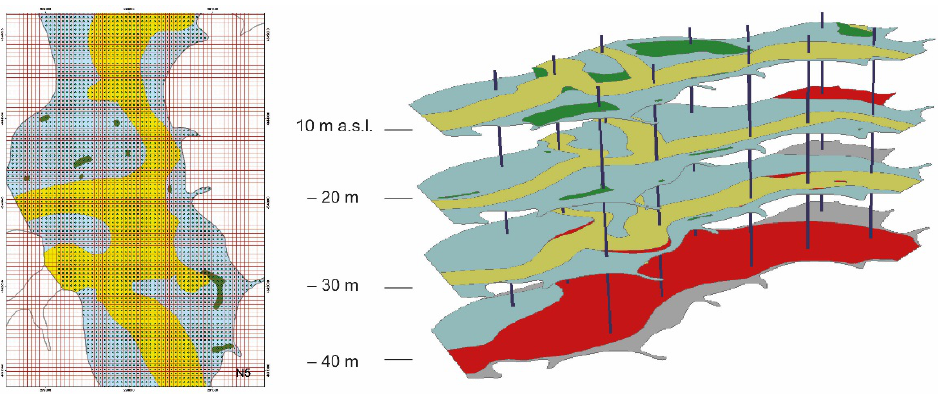
Figure 6. Rasterization of the model with a cell resolution of 50 m, on the left. On the right, reconstruction of paleoenvironments in the Tiber River valley. Active channel and channel-levee areas (red for gravels, and yellow for sands and silty sands) and drained and undrained floodplain (blue for clays, and green for peats) are mapped at different depths. In gray are the lithotypes of the substrate. Vertical boreholes (black lines) used to constrain the model are also reported.